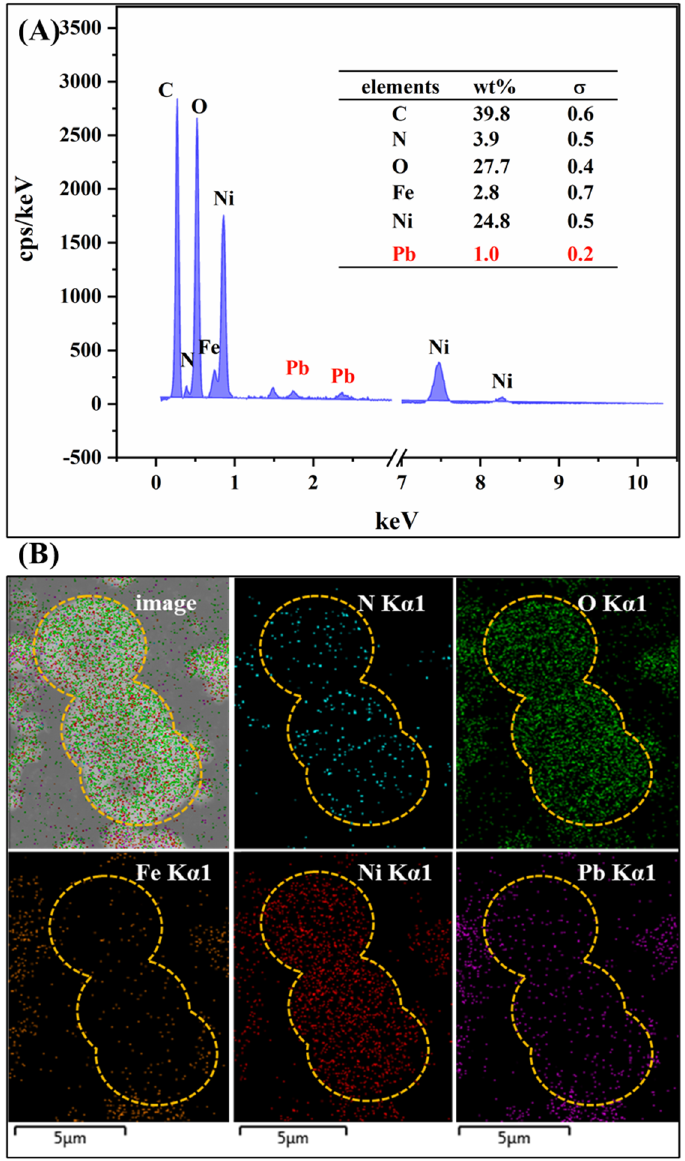
Figure 7. ( A ) SEM-EDX and ( B ) element mapping of MIL-88A-LDHs/Pb 2+ .